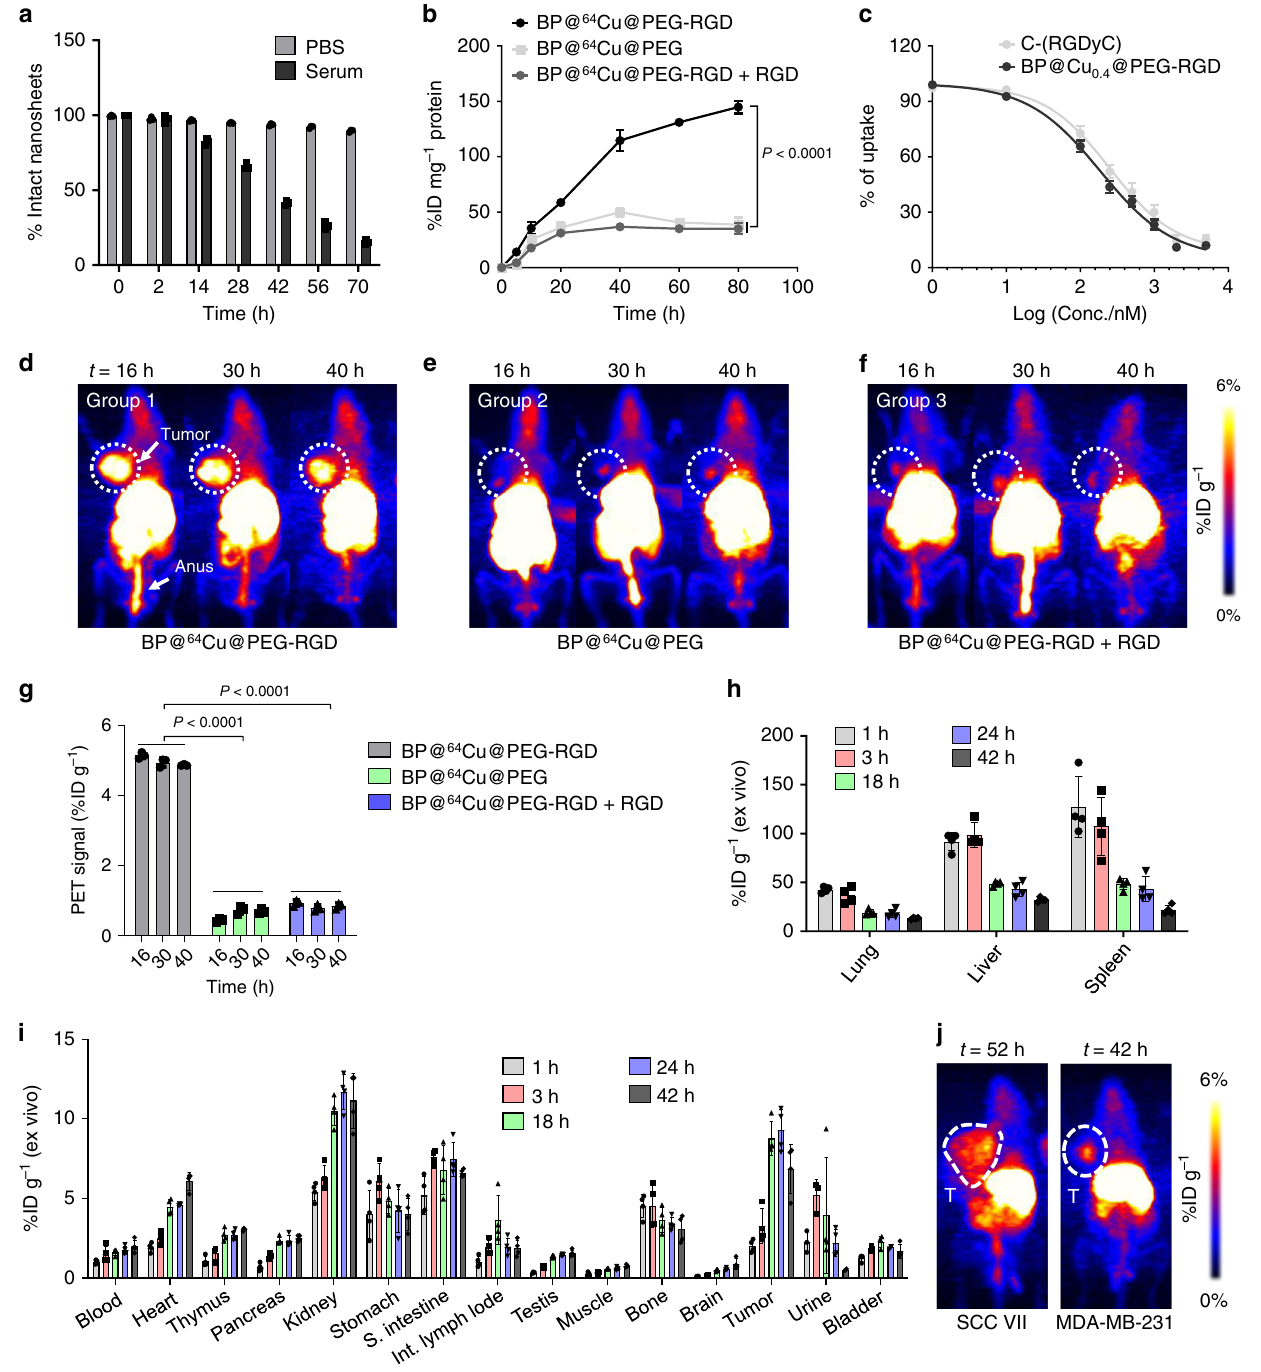
Fig. 6 Tumor-targeting properties of BP@ 64 Cu@PEG-RGD. a Stability of BP@ 64 Cu@PEG-RGD in PBS and mouse serum. Data represents the mean ± s.d., n = 3. b Time-uptake curves of BP@ 64 Cu@PEG-RGD, BP@ 64 Cu@PEG, and BP@ 64 Cu@PEG-RGD + RGD in B16F10 cells, mean ± s.d., n = 3. Analyzed by two-way ANOVA, followed by Tukey ’ s multiple comparisons post-test. c Competition binding of BP@ 64 Cu@PEG-RGD by various concentrations of c (RGDyC) or BP@Cu@PEG-RGD. The data represents the mean ± s.d., n = 3 biologically independent cells. d – f MIP PET images of B16F10 tumor-bearing mice at 16, 30, and 40 h after intravenous injection of BP@ 64 Cu@PEG-RGD, BP@ 64 Cu@PEG, or BP@ 64 Cu@PEG-RGD + RGD, respectively. For the BP@ 64 Cu@PEG-RGD + RGD group, the c(RGDyC) peptide (5 mg/kg) was co-injected with BP@ 64 Cu@PEG-RGD. The white circles denote the tumor sites. g Quanti fi cation of radioactivity in the tumor from the PET images. The data show mean ± s.d., n = 3. Analyzed by two-way ANOVA, followed by Tukey ’ s multiple comparisons post-test. h , i Ex vivo biodistribution of BP@ 64 Cu@PEG-RGD in tumor and major organs of mice bearing B16F10 tumor at 1, 3, 18, 24, and 42 h p.i. Each point corresponds to mean ± s.d., n = 4. j MIP PET images of BP@ 64 Cu@PEG-RGD in SCC VII and MDA-MB-231 tumor-bearing mice 52 or 42 h p.i., respectively. The white circles denote the tumor sites. All error bars in this fi gure indicate standard